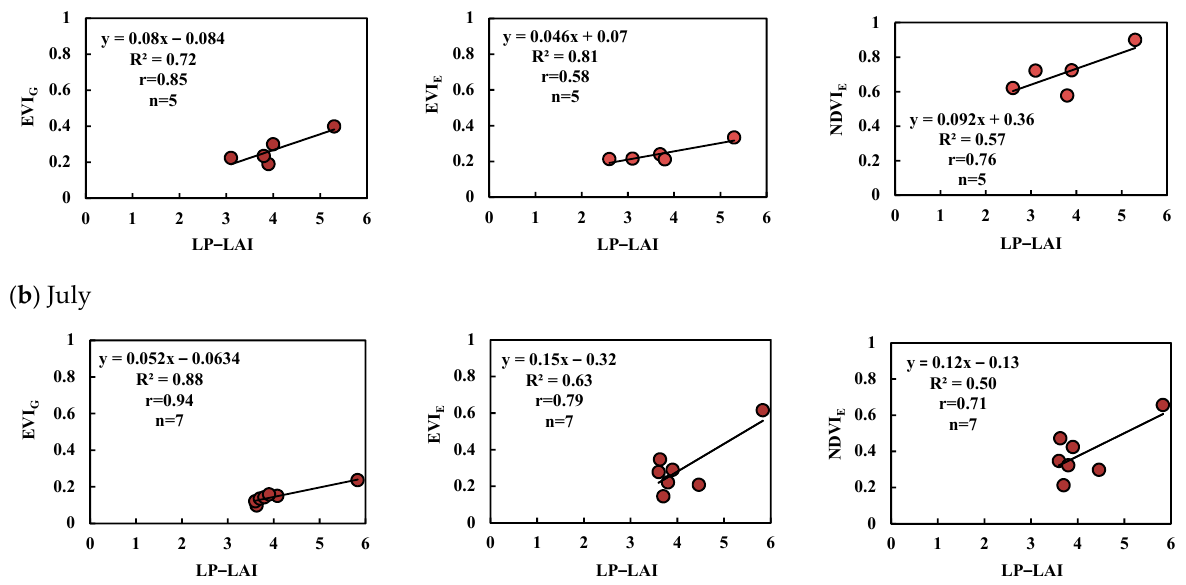
Figure 9. Scatter plots of vegetation indices and LP-LAIs in ( a ) June and ( b ) July. Table 7. Results of accuracy assessment for each study month and PFTs.